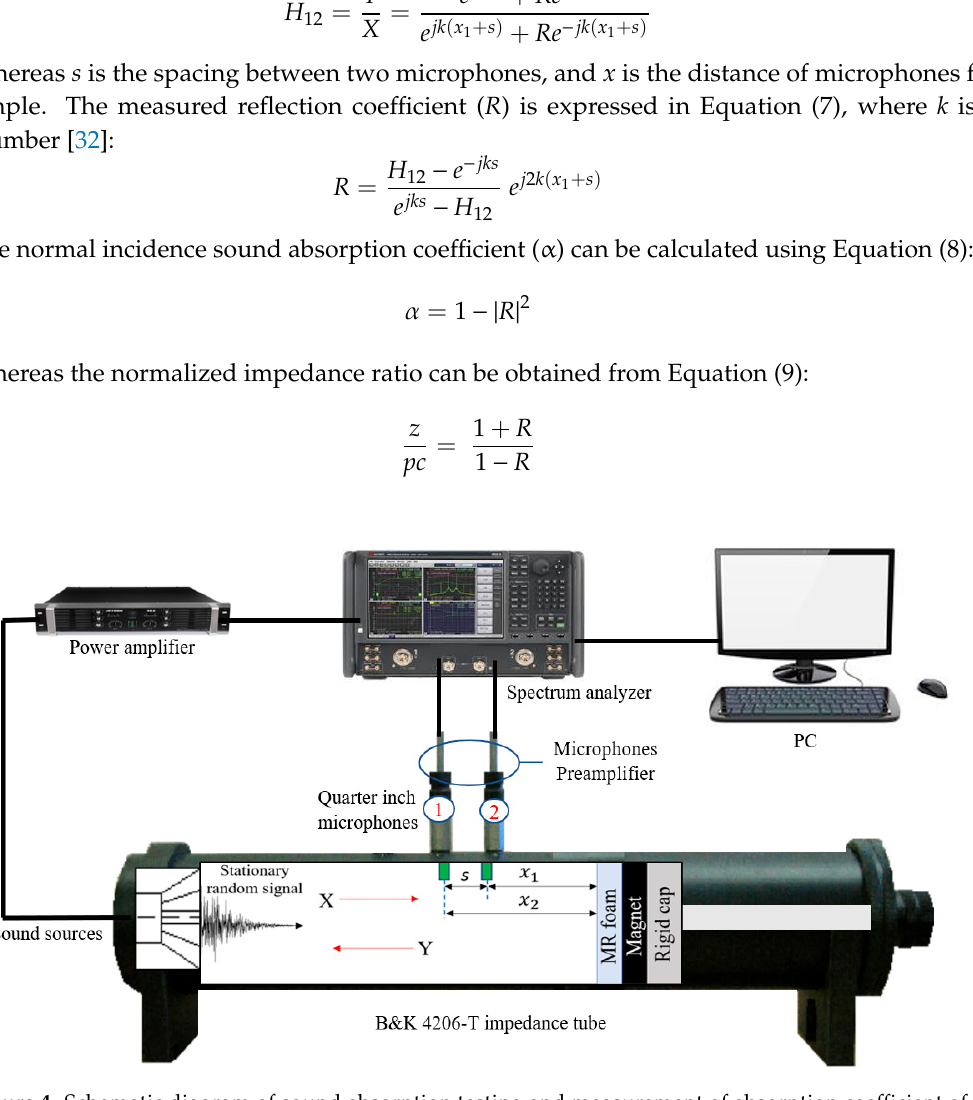
Figure 4. Schematic diagram of sound absorption testing and measurement of absorption coefficient of MR foam.